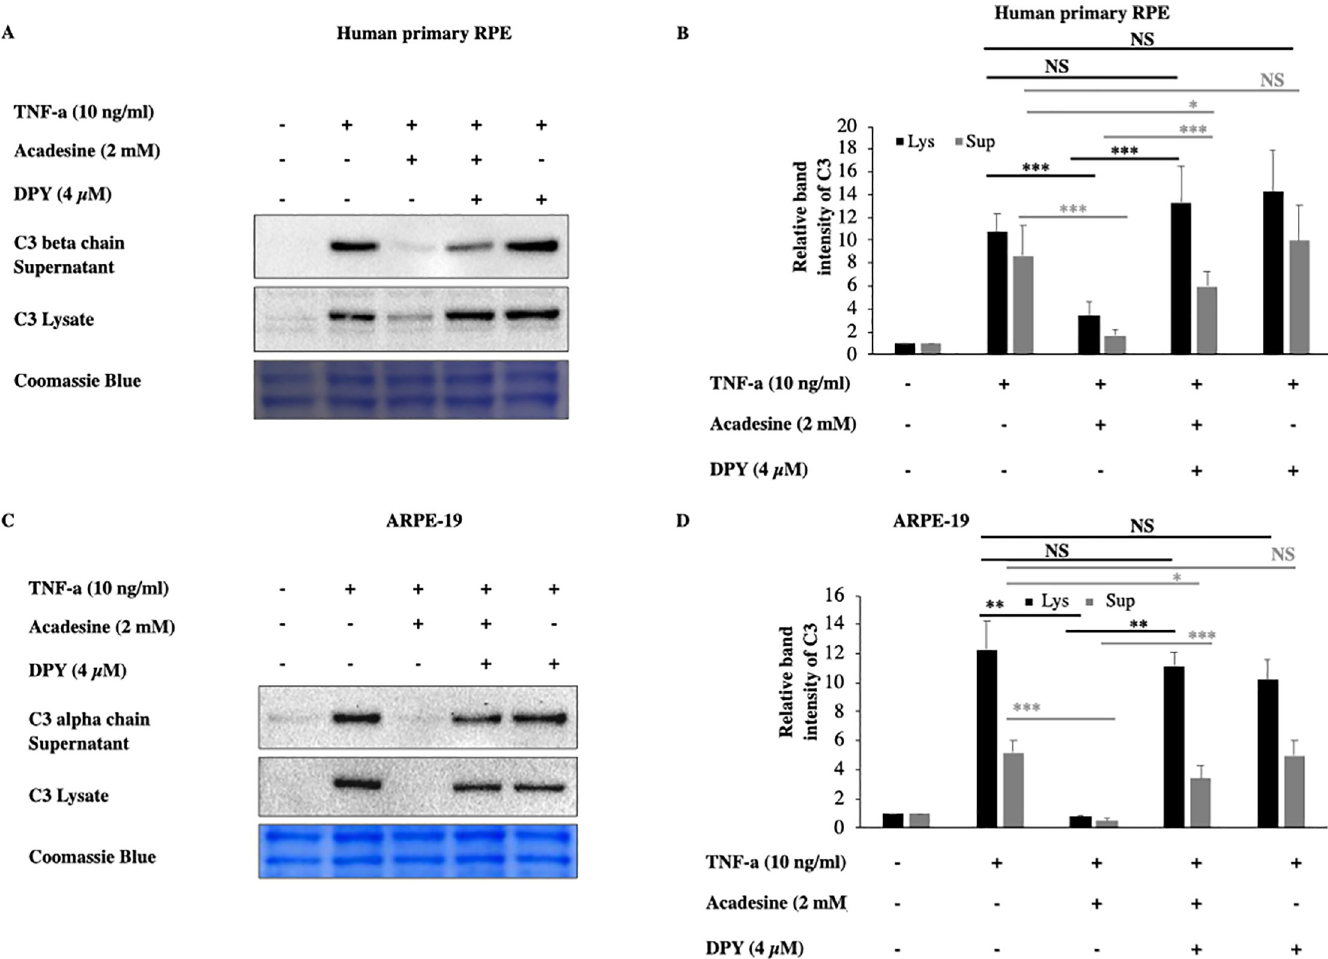
Fig 2. Dipyridamole abolishes the inhibitory effects of acadesine on TNF- α induced C3 expression. Following 24 hours starvation by serum depletion RPE cells were pretreated with dipyridamole (4 μ M) for 1 hour and then treated with acadesine (2mM) for 1 hour before stimulation with TNF- α (10ng/ml) for additional 24 hours. Pretreatment with dipyridamole prevented acadesine from exerting its inhibitory effects as seen in A. Western blot representing the expression levels of C3 in human primary RPE cell lysates and supernatants. B. Densitometry analysis of C3 levels in human primary RPE cell lysates and supernatants. C. Western blot representing the expression levels of C3 in ARPE-19 cell lysates and supernatants. D. Densitometry analysis of C3 levels in ARPE-19 cell lysates and supernatants. Each group represents the mean of at least three independent experiments. � p < 0.05, �� p < 0.01, ��� p < 0.001. Coomassie blue indicates the relative loading of the